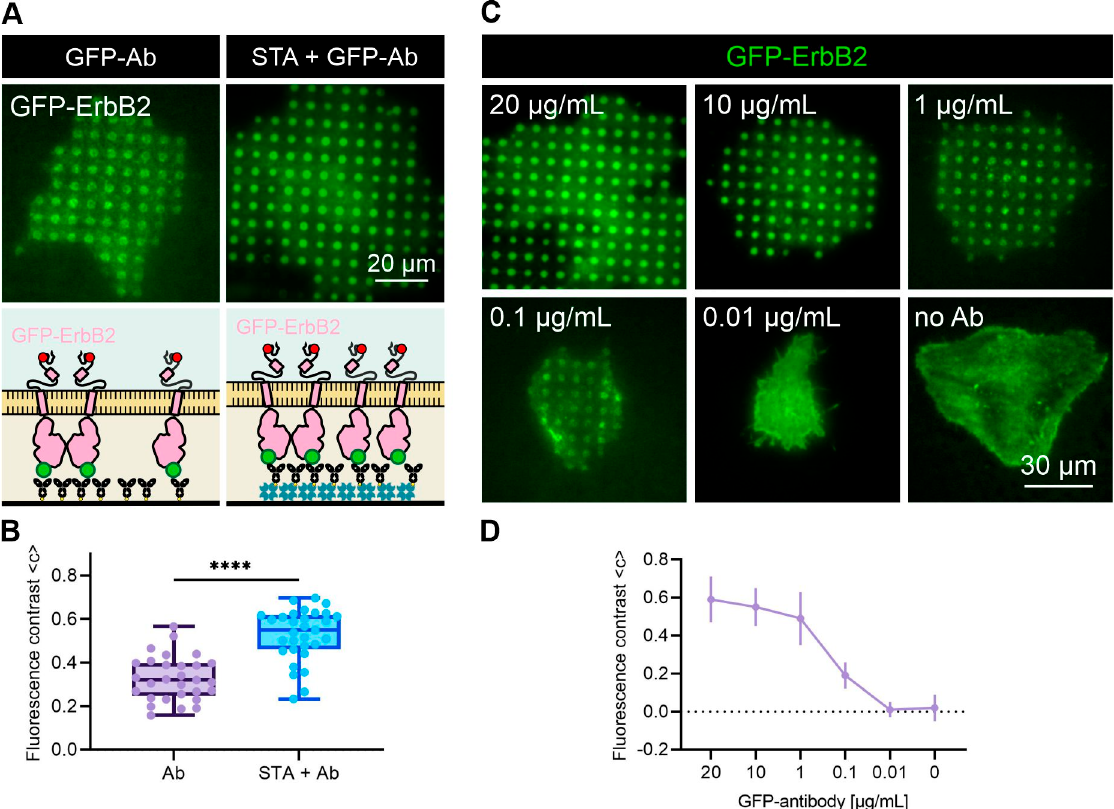
Figure 4. Evaluation of antibody specificity. ( A ) Representative TIRF microscopy images of GFP- ErbB2 expressing cells grown on solely anti-GFP antibody-patterned surfaces (left) and with an additional STA layer in between (right). ( B ) Box plots show quantitation of GFP contrast of cells grown under indicated conditions ( n > 29 cells; **** p < 0.0001 for comparison of the two different conditions). ( C ) Representative TIRF microscopy images of GFP-ErbB2-expressing cells grown on surfaces bearing different concentrations of anti-GFP antibody. ( D ) Dot plot shows quantitation of antibody concentration-dependent mean GFP contrast ( n = 20 cells per